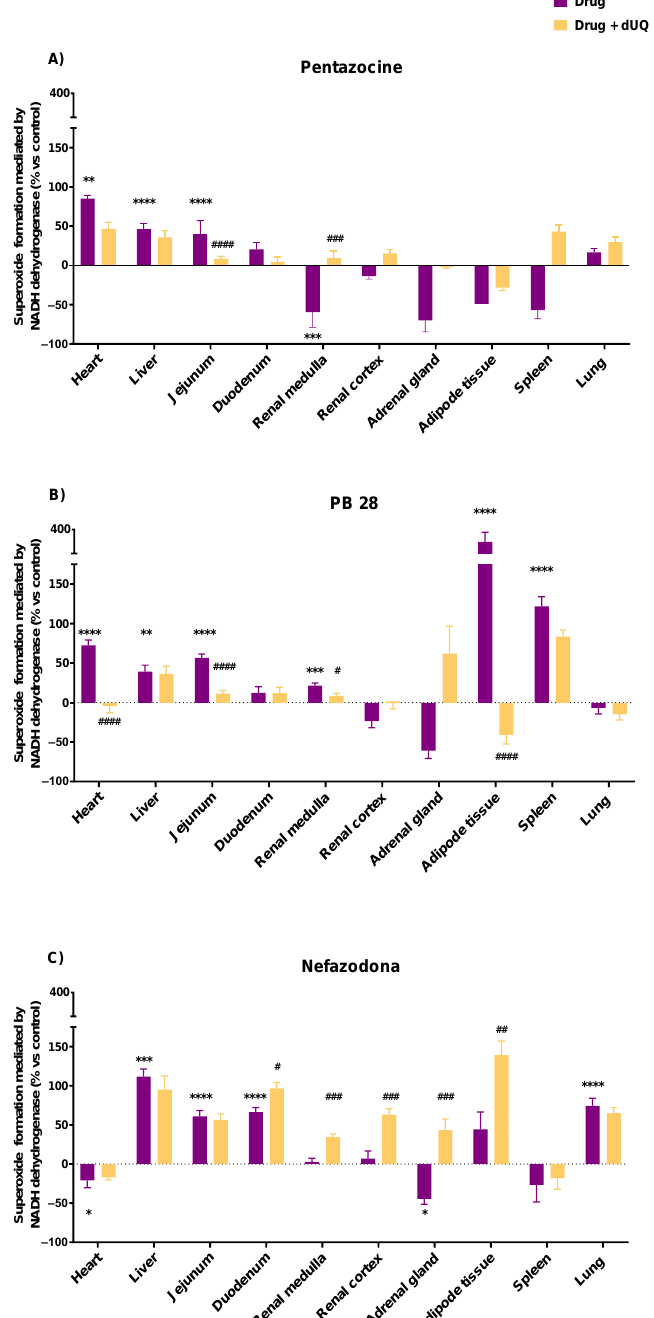
Figure 6. ( A ) NADH-mediated superoxide formation promoted by pentazocine in different human tissues in the presence and absence of decylubiquinone, ( B ) NADH-mediated superoxide formation promoted by PB28 in different human tissues in the presence and absence of decylubiquinone ( C ) NADH-mediated superoxide formation promoted by nefazodone in different human tissues in the presence and absence of decylubiquinone in different human tissues in the presence and absence of decylubiquinone. Results expressed as percentages of increase versus the basal activity without the drug (mean ± SEM). Shapiro–Wilk test was performed to test normality. For the tissues that present a Gaussian distribution, one-way ANOVA statistical test with α : 0.05 was performed. For tissues without a normal distribution, a Kruskal–Wallis statistical test with α : 0.05 was performed. * p < 0.05; ** p < 0.01; *** p < 0.001; **** p < 0.0001 drug vs. control; # p < 0.05; ## p < 0.01; ### p < 0.001; and #### p < 0.0001 drug alone vs. drug +